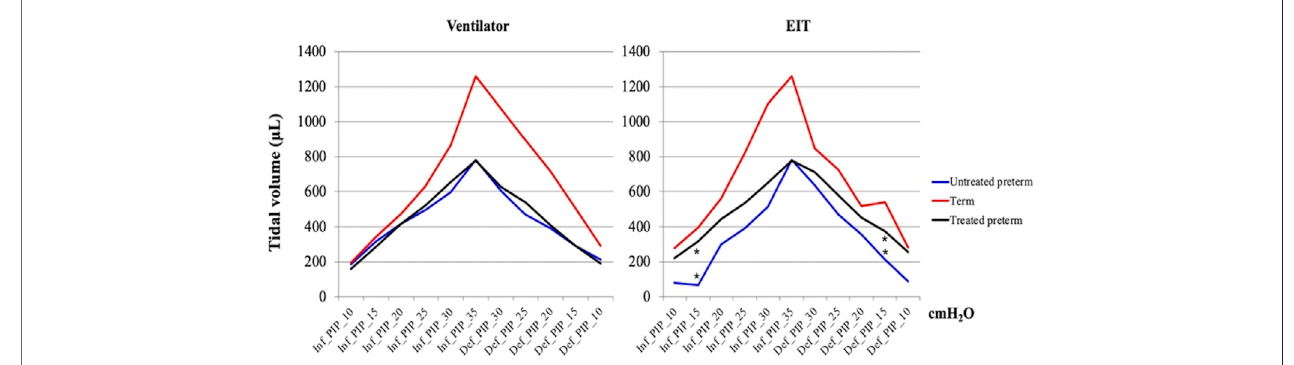
FIGURE 2 | Pressure-volume curves. The graphs were based on the median values of the untreated preterm group ( n = 9), surfactant treated group ( n = 6), and term group ( n = 3). Maximum and minimum values are shown in Table 1 . * means statistical signi fi cance between the untreated preterm group and surfactant treated